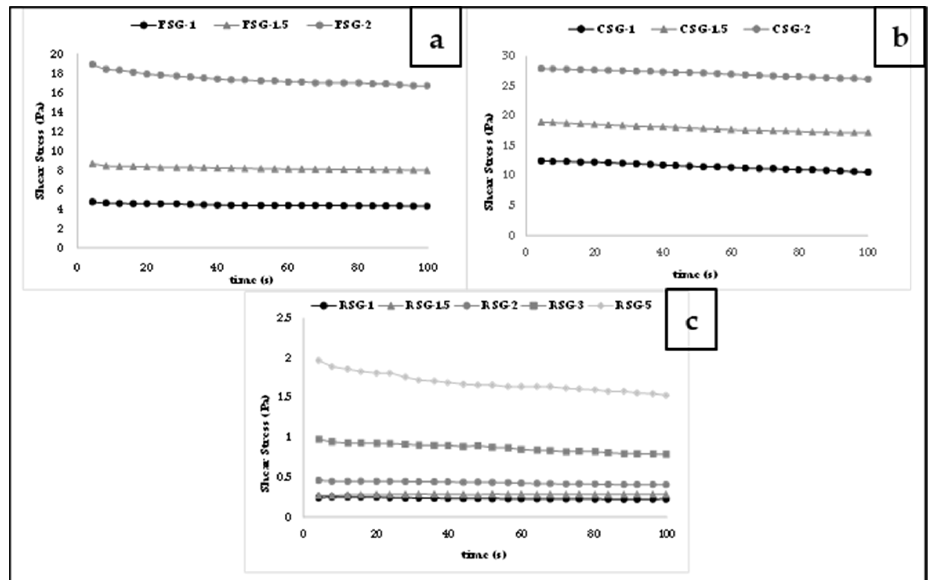
Figure 4. Shear stress vs time at a constant shear rate (0.5 s − 1 ) for CSG: chia seed byproduct gum, FSG: flaxseed byproduct gum, RSG: rocket seed byproduct gum solutions with different concentrations (( a ) CSG (1–2%), ( b ) FSG (1–2%), ( c ) RSG (1–5%)).